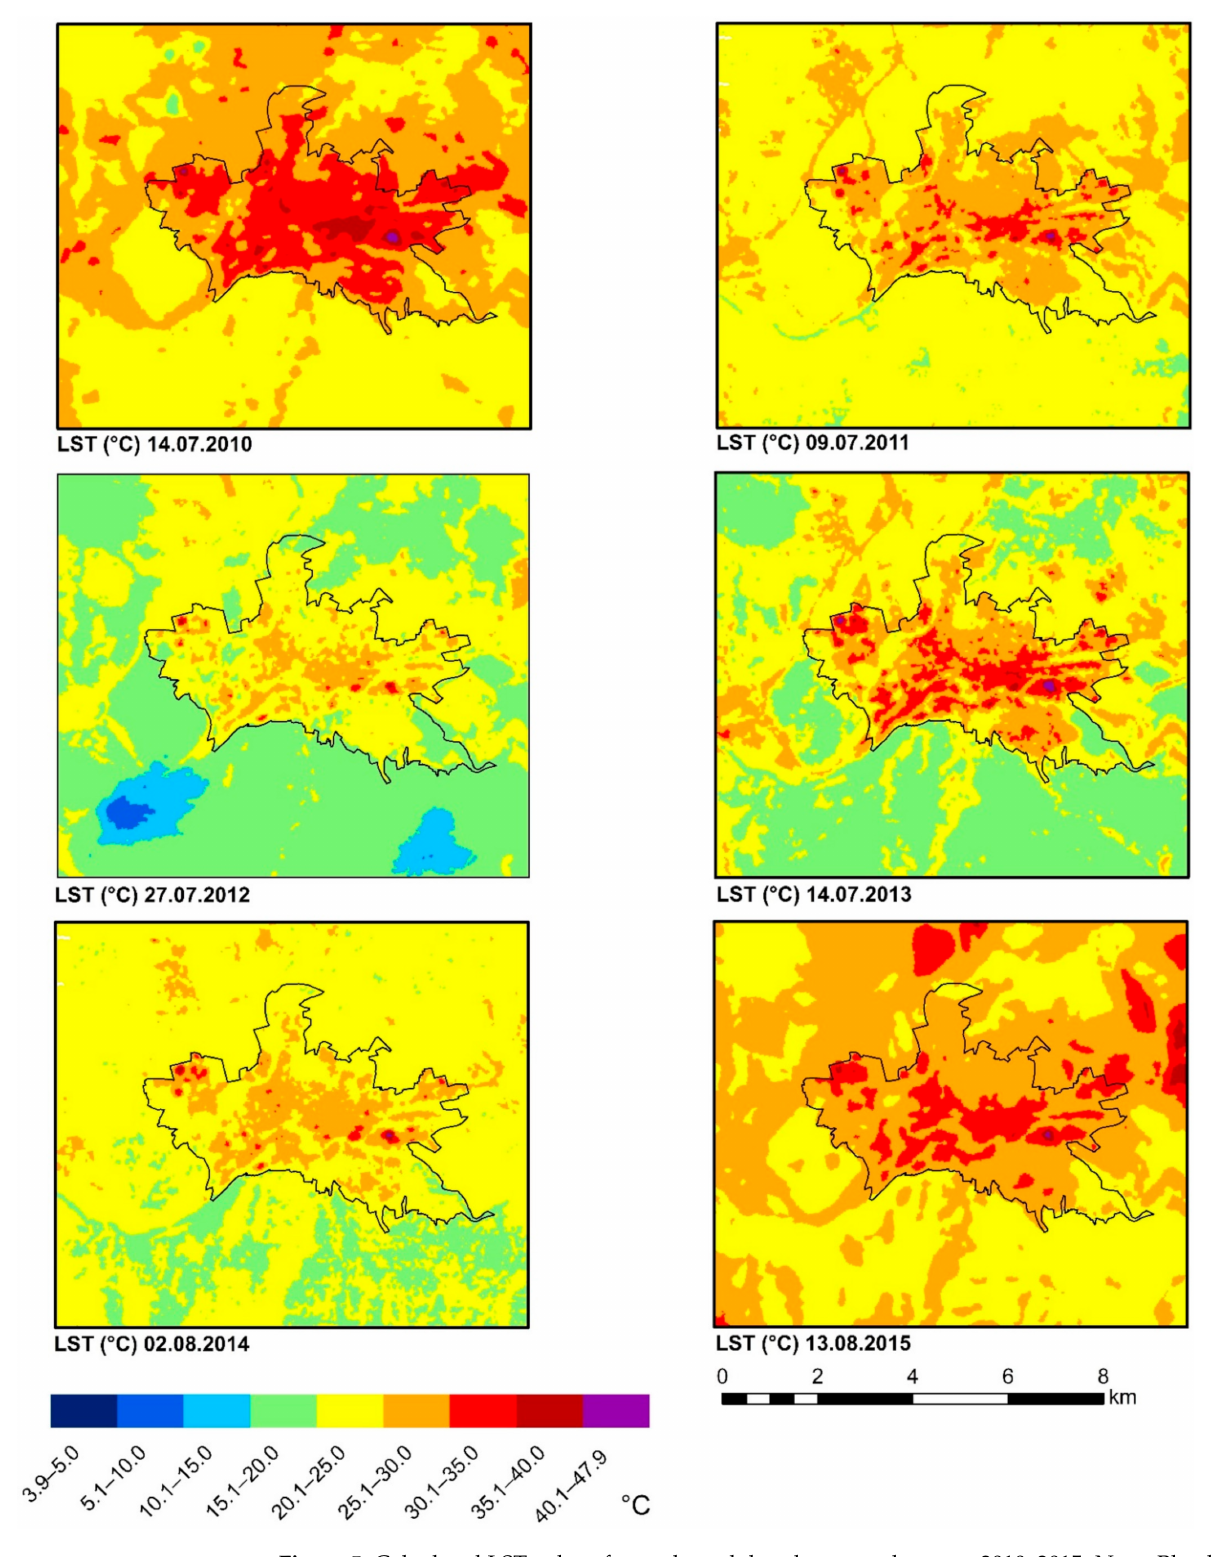
Figure 5. Calculated LST values for evaluated days between the years 2010–2015. Note: Blue blobs (temperatures under 15 ◦ C) in 2012 were covered by